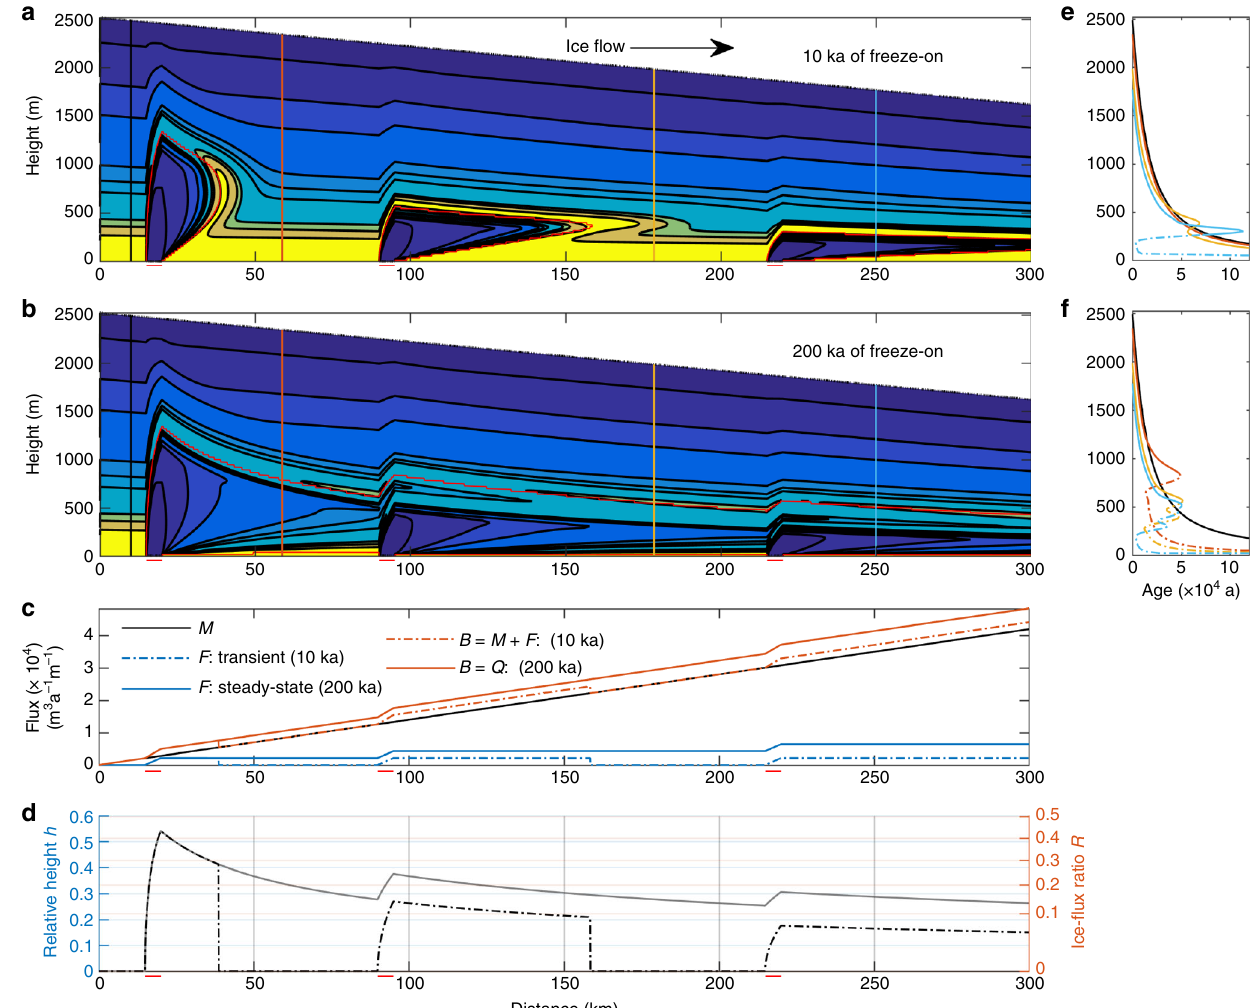
Fig. 5 Plume size, internal layer structure and accretionary-meteoric ice- fl ux contributions along ice-sheet fl ow. Modelled internal layers along fl ow ( fl ow purely by ice deformation) with meteoric-to-accreted ice interface (red outline) after application of a freeze-on rate of ( _ f ¼ 0 : 42 ma (cid:2) 1 ) over three accretion regions of 5 km extent. Surface accumulation ( _ a ¼ 0 : 14 ma (cid:2) 1 ), surface slope and background melt (10 − 6 m a − 1 ) are constant over time. a Transient run after 10,000 years. b Steady-state run (200,000 years). c Meteoric ice fl ux M shown together with freeze-on fl ux F and balance fl ux B . d Ice- fl ux ratio R (right y -axis) and relative plume height h (left y -axis) for ice fl ow by internal ice deformation only, shown for both 10 ka (black dashed- dotted line) and 200 ka (grey solid line) of freeze-on. e , f Age-depth relationship for vertical pro fi les in a , b for meteoric (solid line) and plume ice (dashed line) compared to an undisturbed pro fi le (black solid line). Note, age contours chosen as in Fig.